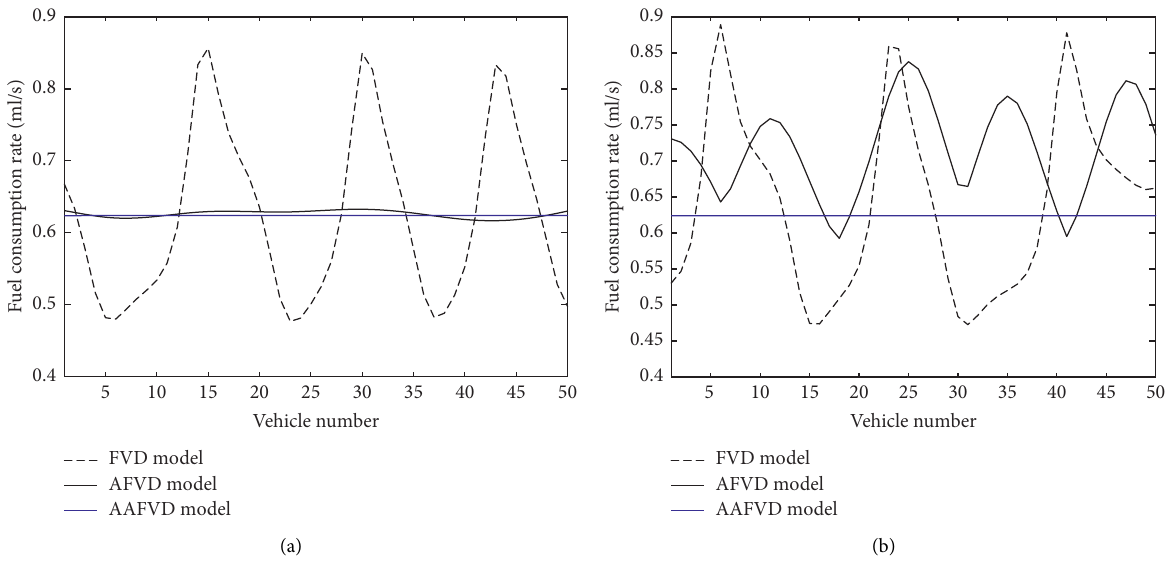
Figure 16: Snapshots of energy consumption rate of 50 vehicles simulated by the FVD model, AFVD model ( T � 0, p � 0), and AAFVD model ( T � 0.1, p � 0 . 3) at time step (a) 500s and (b) 1000s.